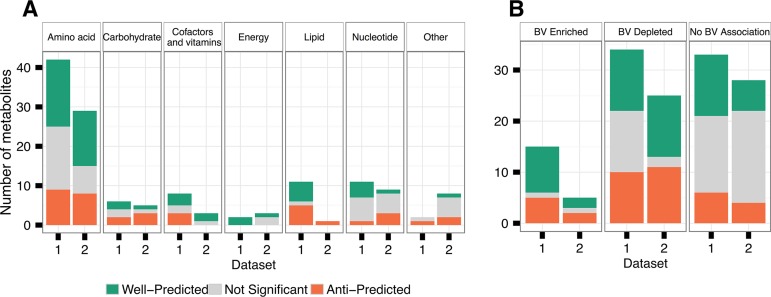
Metabolite predictability across metabolic categories (A) and disease states (B) in the vaginal microbiome. Well-predicted metabolites are defined as those for which variation in CMP scores is significantly correlated (using a Mantel test) with variation in measured metabolite abundance at a false discovery rate (FDR) of 0.01. Anti-predicted metabolites are similarly defined as those for which variation in CMP scores is significantly negatively correlated with variation in measured metabolite abundances (FDR 0.01). Metabolic categorization is based on KEGG data, and disease enrichment is based on a Wilcoxon rank sum test for association with bacterial vaginosis (BV) with a Bonferroni-corrected P value of <0.1.